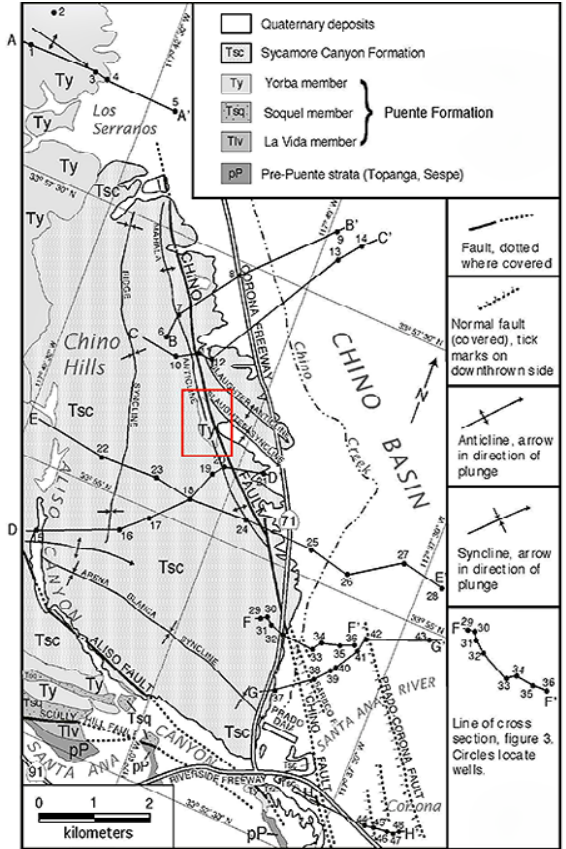
Figure 3. Geological map of the Chino Hills (Madden & Yeats, 2008)